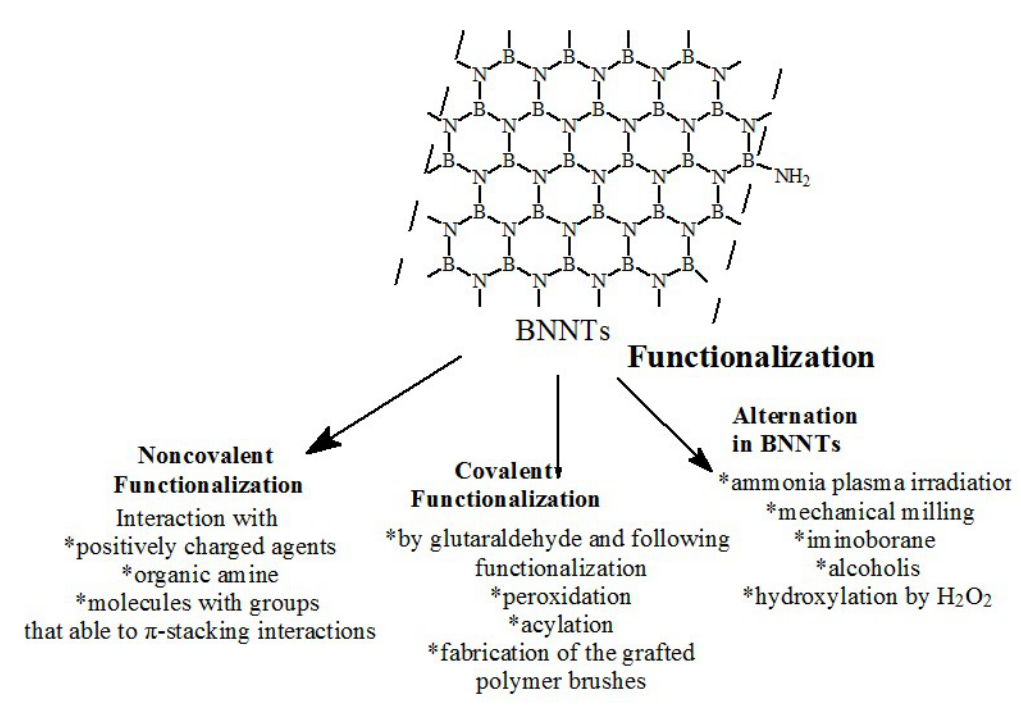
Figure 4. Different approaches for functionalization of the boron nitride nanotubes (BNNTs).